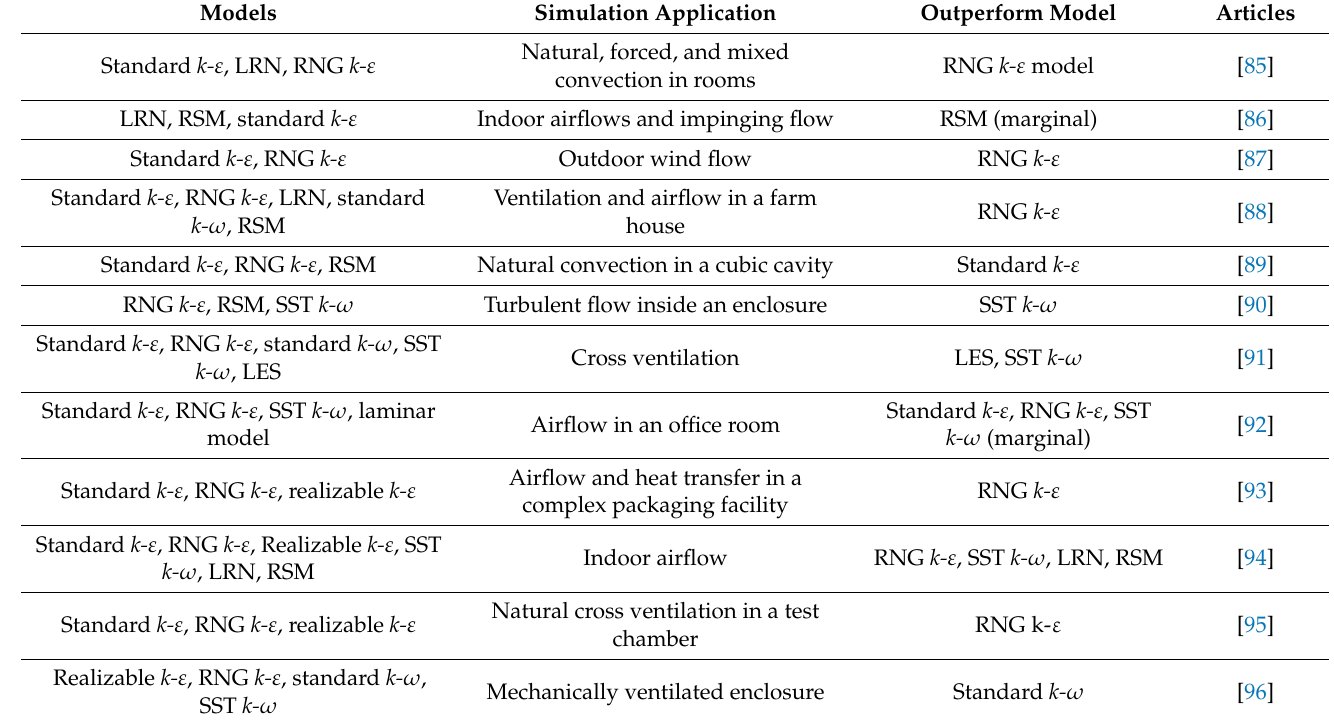
Table 4. Comparison of RANS